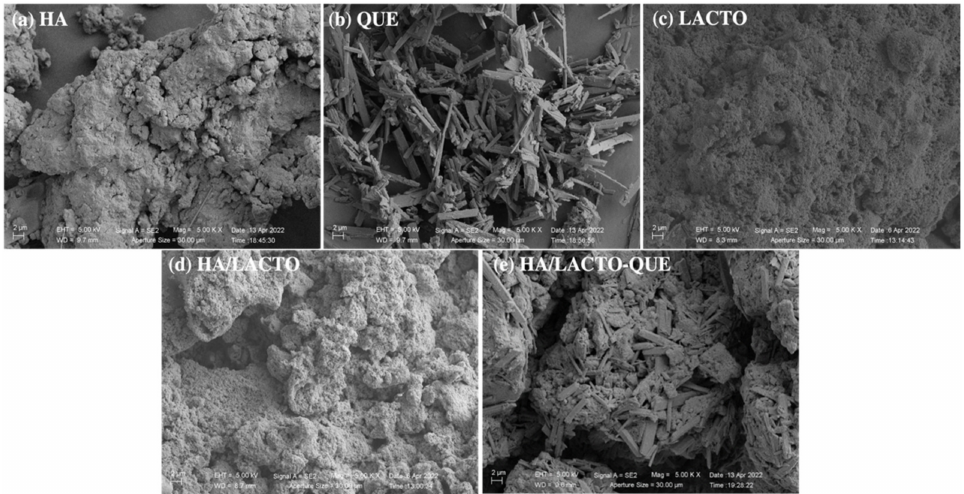
Figure 2. SEM images of HA ( a ), QUE ( b ), LACTO ( c ) HA/LACTO complexes ( d ) and HA/LACTO- QUE ( e )